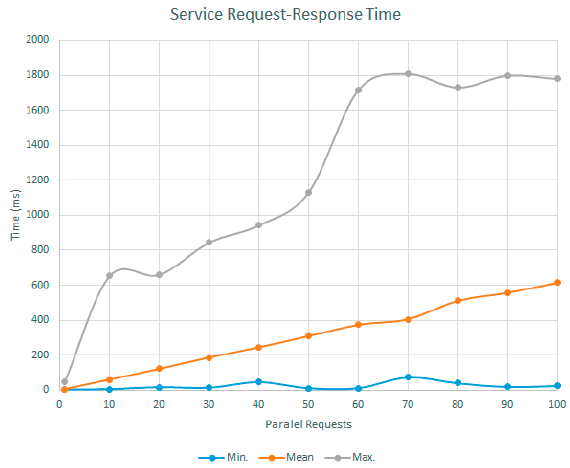
Figure 16. Request-response time of the service implemented in the prototype.